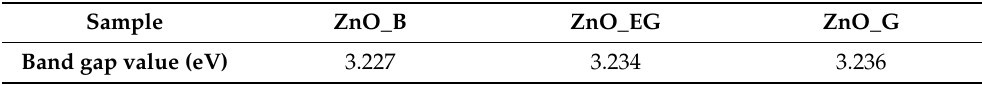
Table 3. The determined band-gap energy values for ZnO nanopowders.